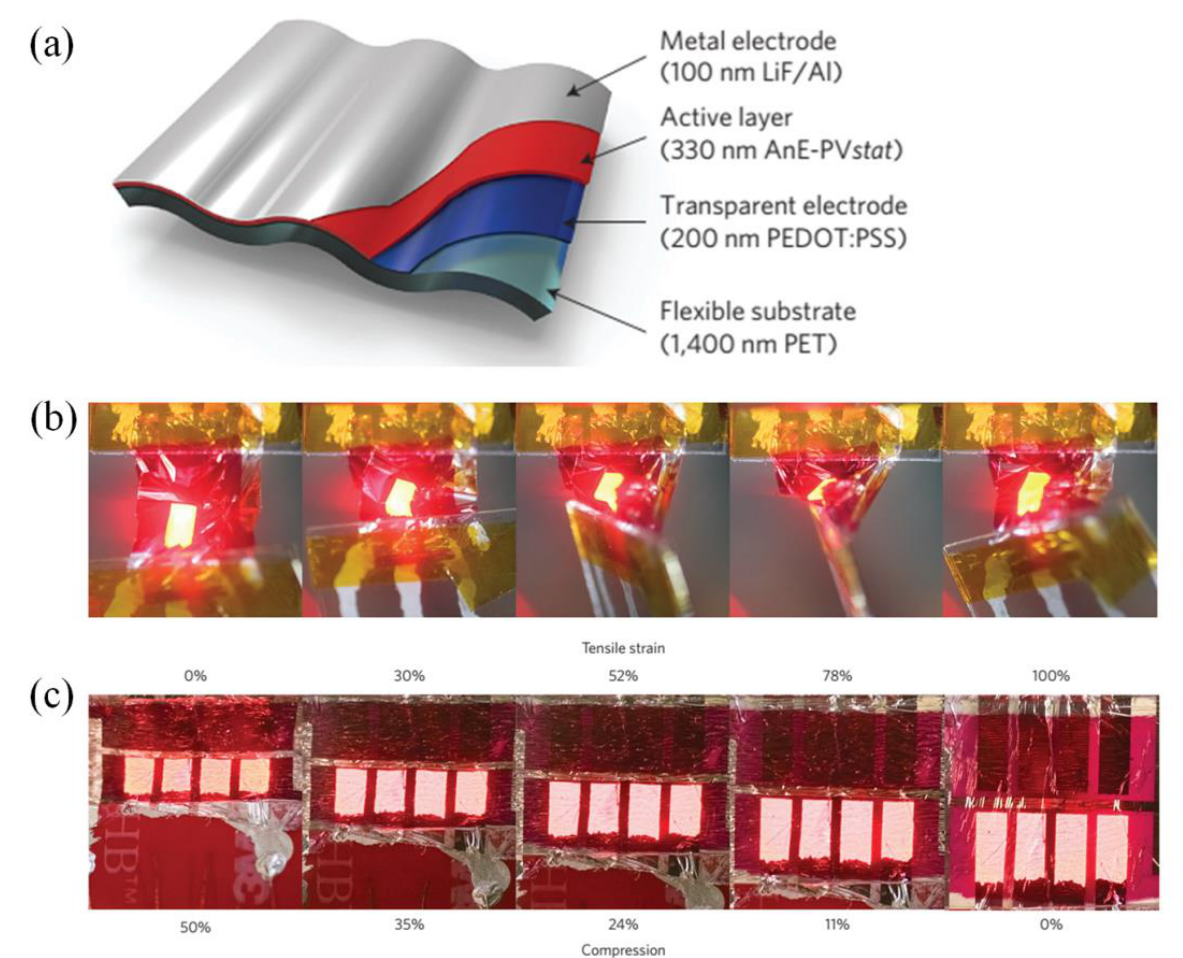
Figure 5: (a) Schematic drawing of the ultrathin PLEDs. (b) Photographs of the ultrathin PLEDs under crumpling test. (c) Photographs of the ultrathin PLEDs adhered onto prestrained elastomer tape. The PLEDs buckled to accommodate the strain after the elastomer was relaxed and could be stretched up to the prestrained state. Reprinted with permission from Macmillan Publishers Ltd: [Nature Photonics] [16], copy- right